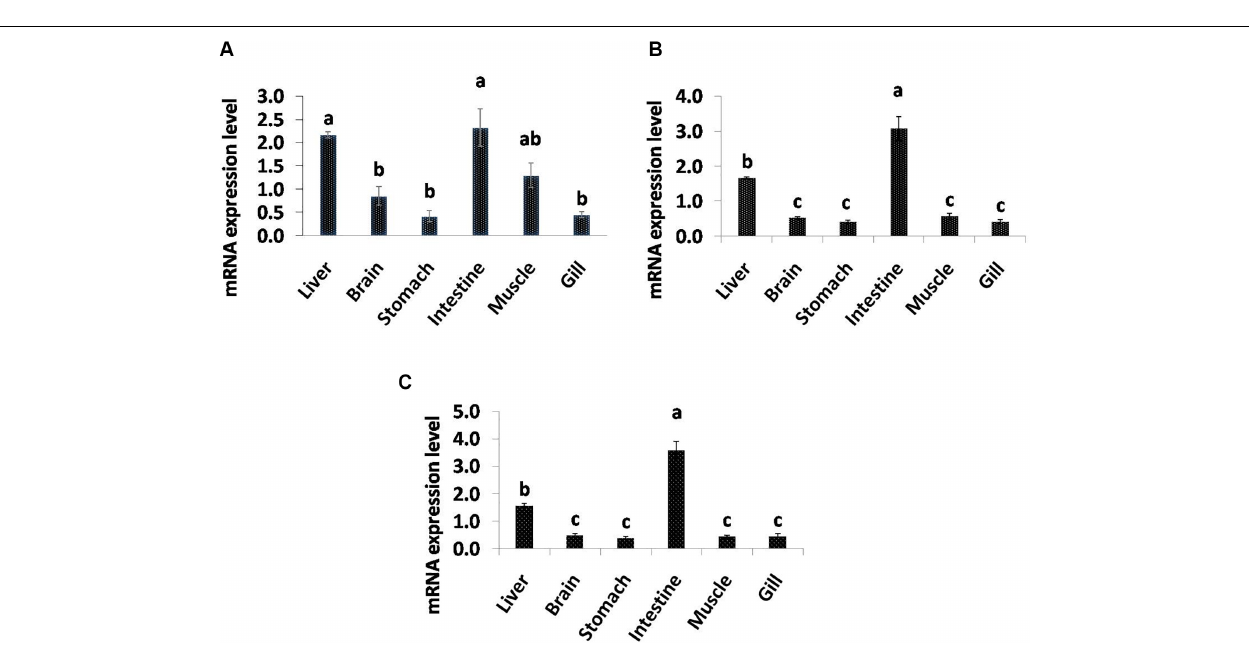
FIGURE 3 | Phylogenetic analysis of C. magur FADS5 putative protein was done using MEGA 7.0 software. Phylogenetic relationship with other piscine and selected mammalian FADS5 proteins. The evolutionary tree was formed using the neighbor-joining method and a bootstrap analysis with 1000 replicates was used to assess the strength of nodes in the tree. Accession numbers are given in the